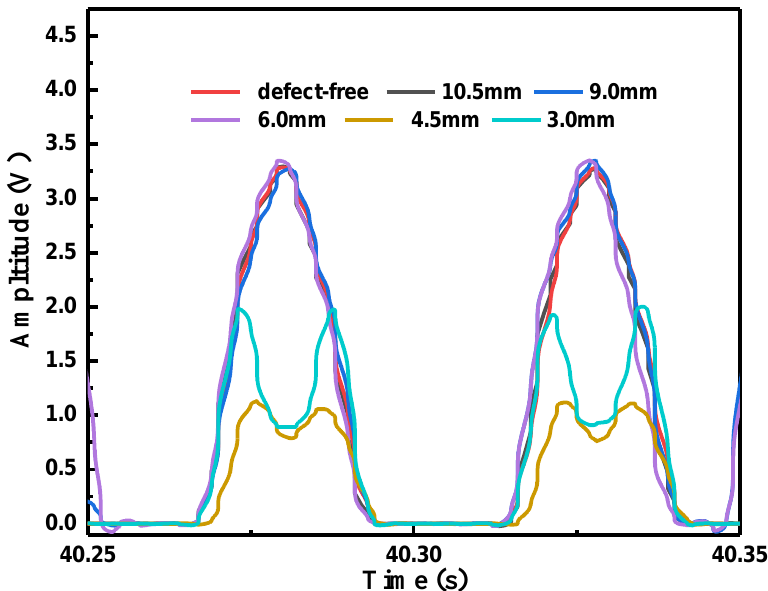
Figure 7. Real-time signals of the leakage magnetic field against different buried depths for ampli- tude detection.